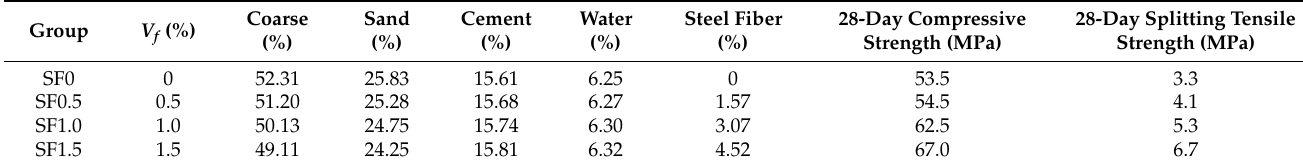
Figure 1. Mix proportions. Table 1. Concrete mix proportions and mechanical performance at room temperature.